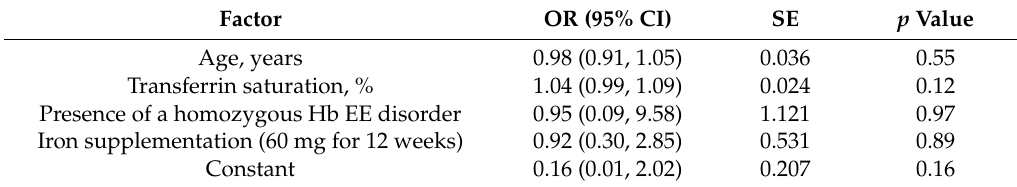
Table 3. Factors associated with elevated serum non-transferrin bound iron (NTBI) concentrations at 12 weeks 1